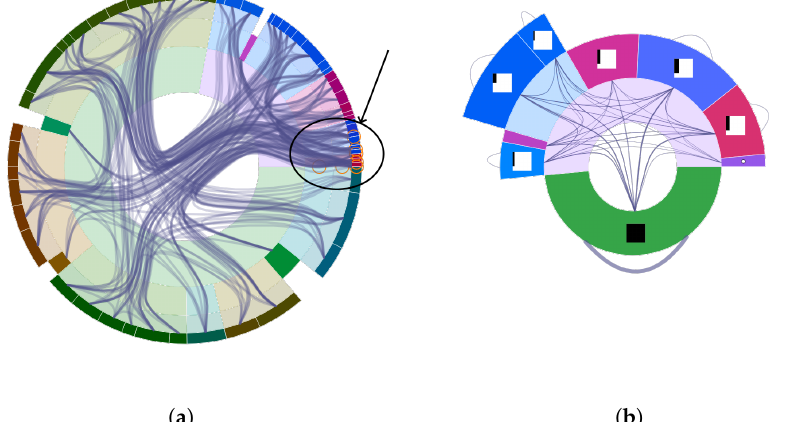
Figure 12. Highlighting or summarizing hidden information. ( a ) The image shows the result of mapping the angle of each sector to its connectivity degree. Those sectors whose angular size turns out to be below a threshold are enclosed in an orange circle, meaning that there is not enough screen space available to render them in detail. ( b ) Relevant features of the hidden tree under each collapsed node are summarized by a simple glyph. In this example, the width of the black filling encodes the number of leaf nodes, while the height of the black filling represents the depth of the hidden